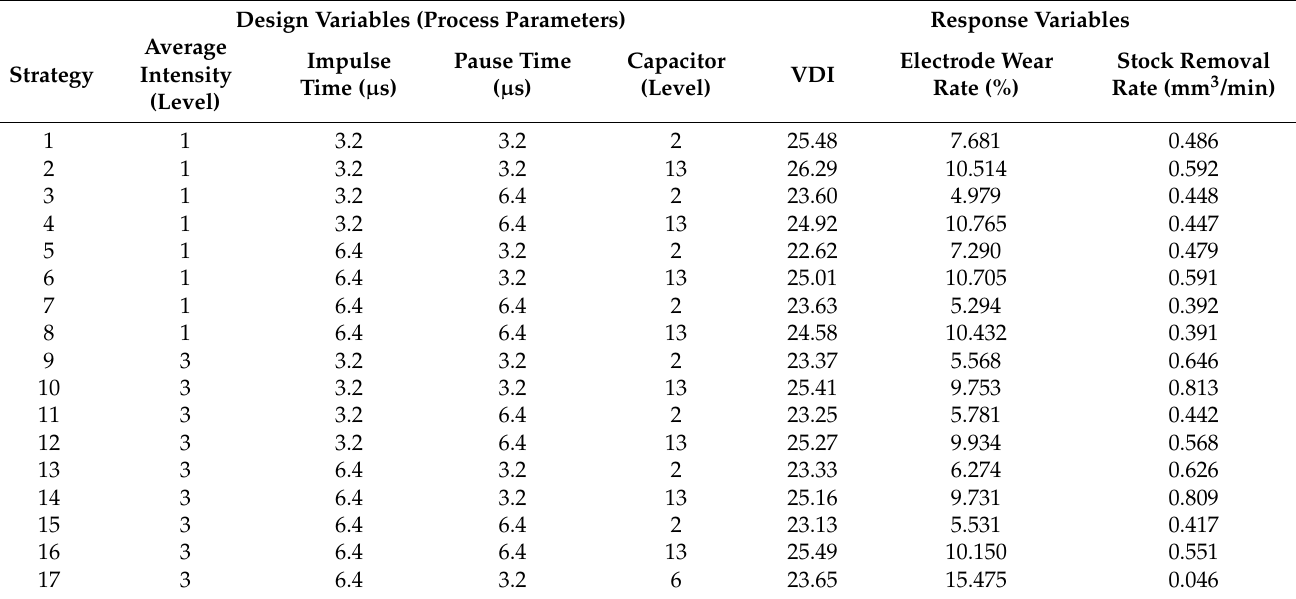
Table 9. Results of test EDM strategies